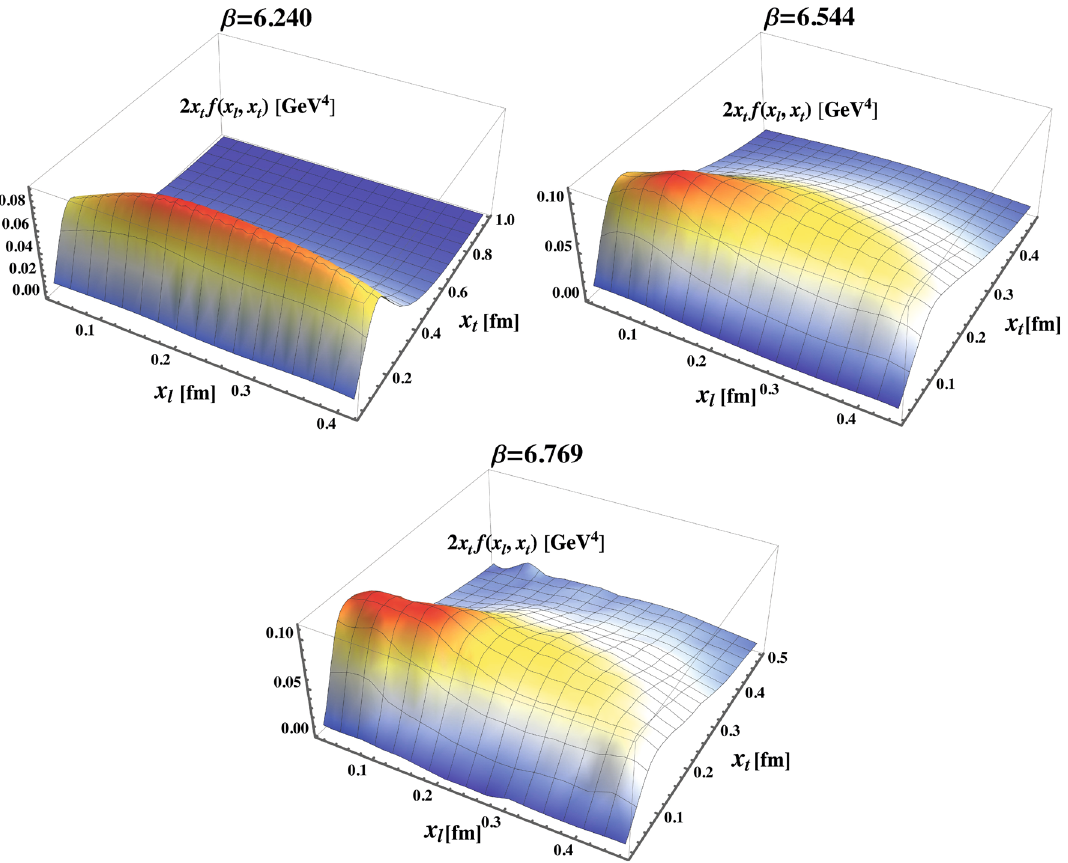
Fig. 9 The integrand of Eq. (18), 2 x t f ( x l , x t ) = 2 x t times the magnetic force density, for three values of β , all corresponding to the same quark–antiquark separation in physical units, d = 0 . 511 f m . The force density falls off for large x t for all values of x l , manifesting confinement